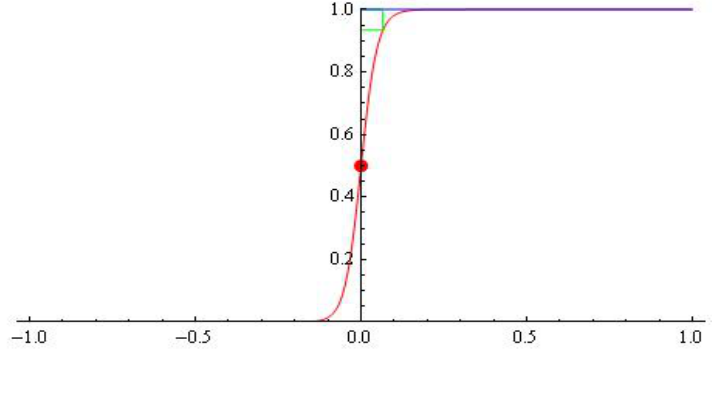
Fig. 2. The model (5) for β = 61 , k = 41 ; H–distance = 0 . 0660383 , d l = 0 . 0232558 , d r = 0 . 133677 .